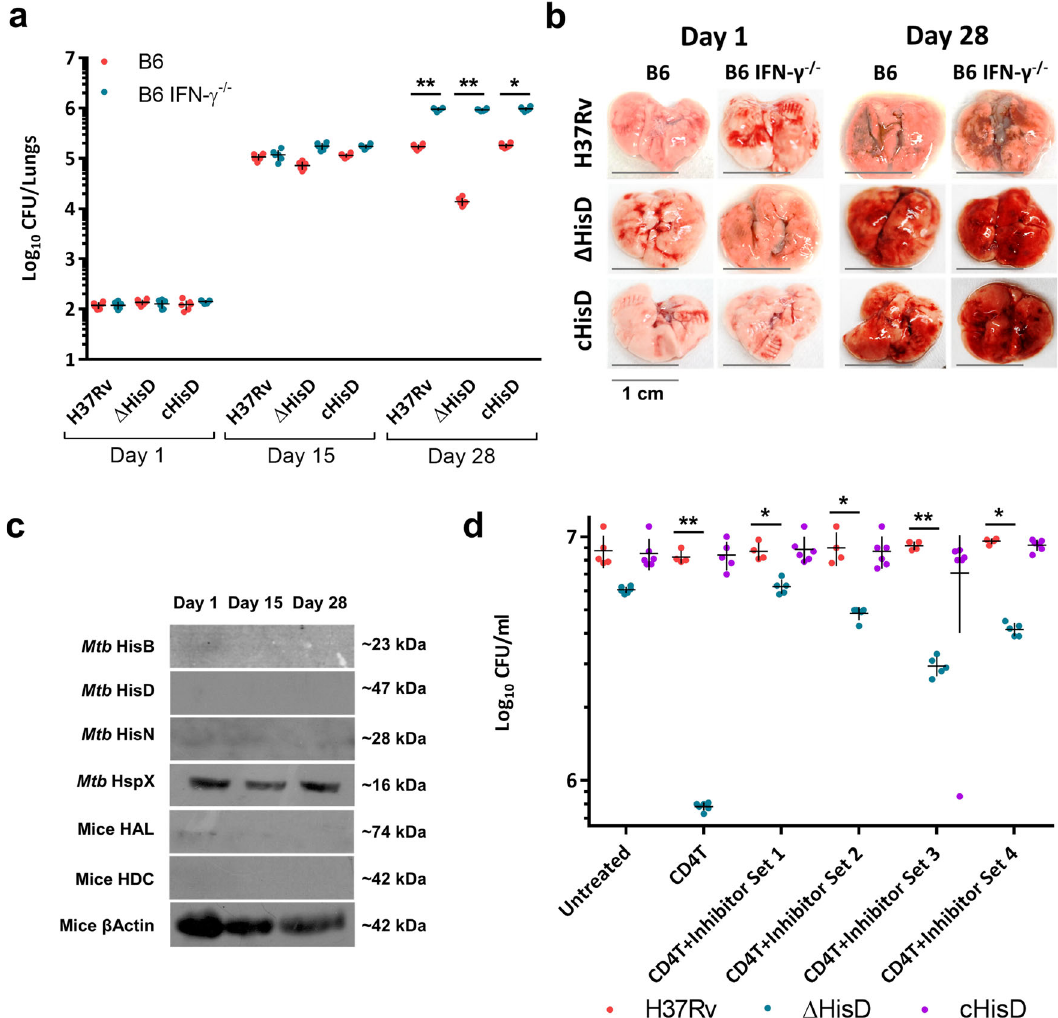
Fig. 5 IFN- γ mediated control of HAL and HDC up-regulation. a A 10-fold decrease in bacillary counts for Δ hisD compared to that of H37Rv and c hisD was detected in infected B6 mice lungs on day 28. In B6 IFN- γ − / − mice however, Δ hisD , c hisD and H37Rv exhibit near identical bacillary counts on day 28 ( n = 6 individual mice per time point; mean and SEM; * P -value < 0.05, ** P -value < 0.005). b A similar extent of lung damage was observed in B6 IFN- γ − / − mice infected with H37Rv, Δ hisD and c hisD on day 28 (pictures are representative of six individual mice lungs samples). c Negligible expression of host histidine sequestering enzymes and Mtb histidine biosynthesis enzymes in the whole lung lysates from B6 IFN- γ − / − mice infected with H37Rv. Mice β -Actin serves as the loading control. (Immunoblots are representative of samples obtained from three mice each time point). d Addition of speci fi c inhibitors of HAL and HDC Δ hisD- infected primary macrophages signi fi cantly reverses the bactericidal effects of CD4 T cell activation, 48 h post infection ( n = 5 independently acquired and cultured primary cells; mean and SEM; ** P -value <